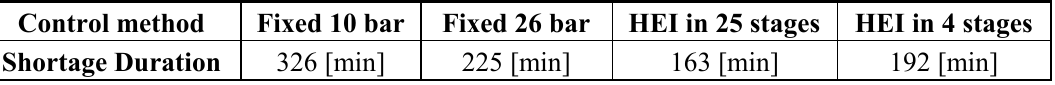
Table 2. The total shortage duration in different compression control strategies.